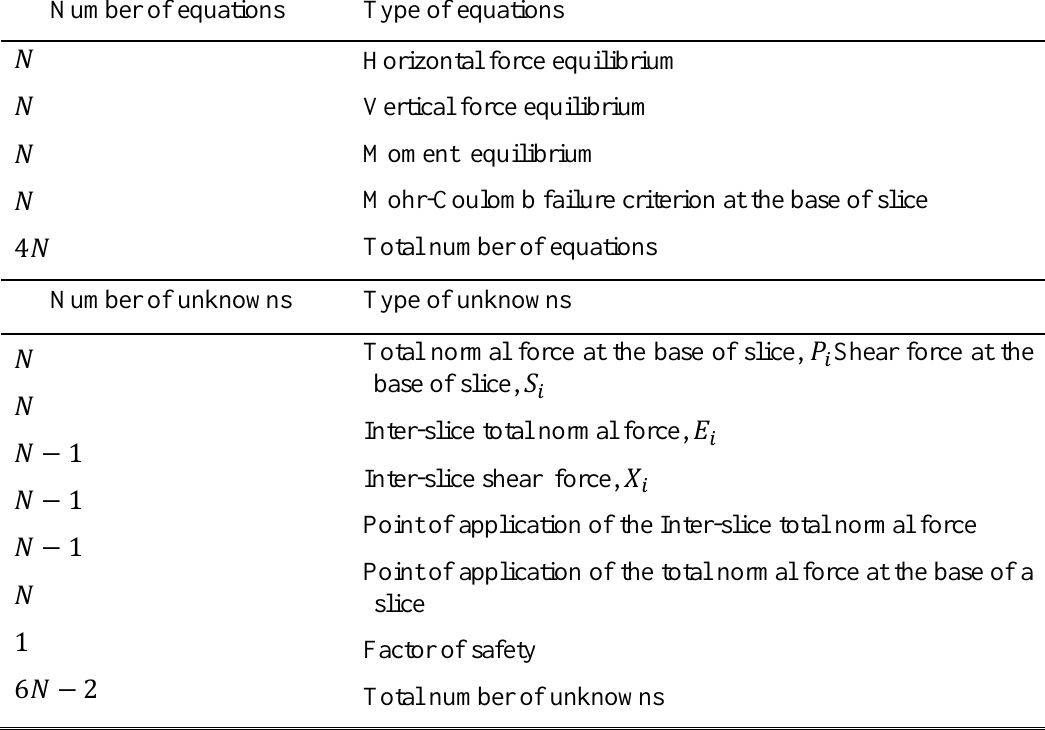
Table 2. Summary of equations and unknowns associated with limit equilibrium methods Number of equations Type of